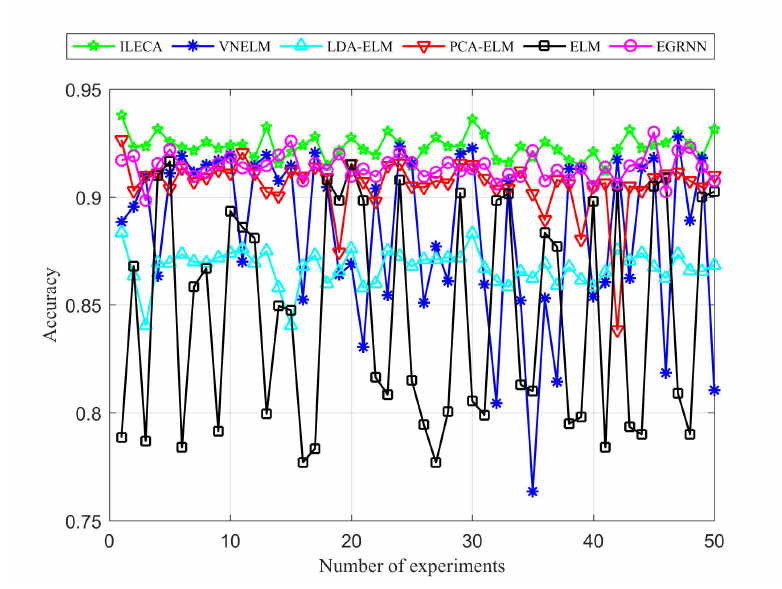
Figure 11. Accuracy of algorithms.